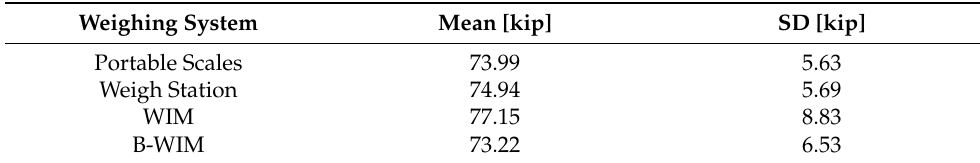
Table 3. Statistical parameters of GVW for all weighing systems.